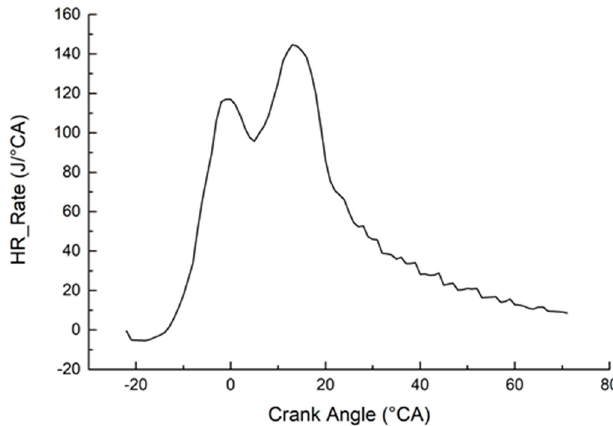
Figure 11. Heat release rate of knock combustion.